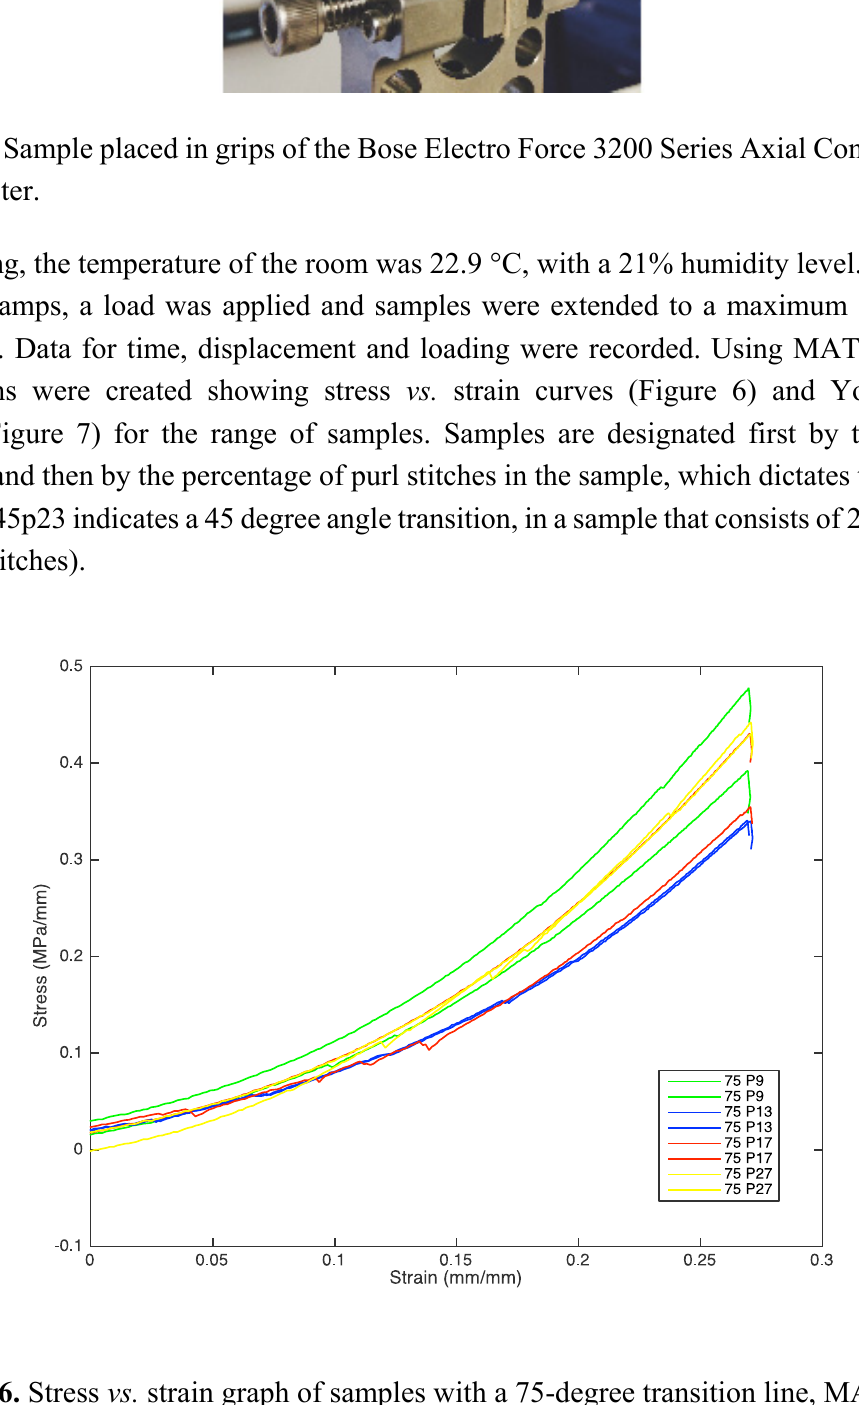
Figure 6. Stress vs. strain graph of samples with a 75-degree transition line,